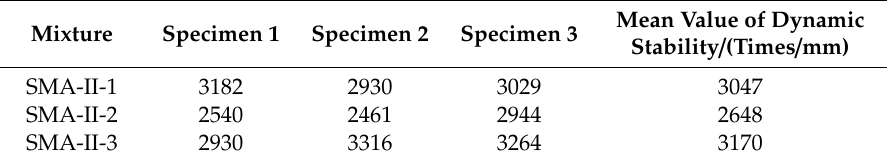
Table 15. Test results of dynamic stability of SMA- Ⅱ .